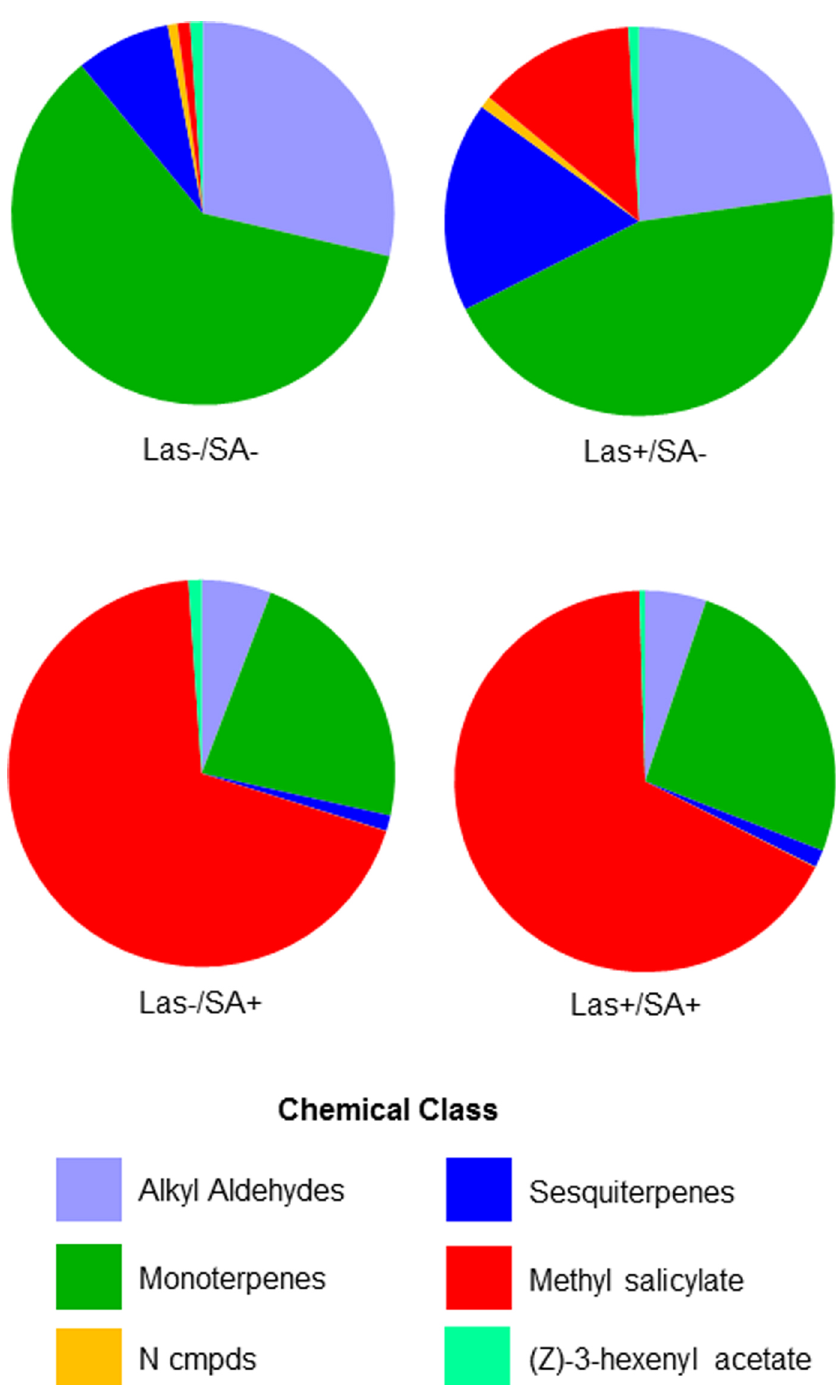
Fig 4. Proportional composition of the individual chemical classes emitted from different treatments in the SA